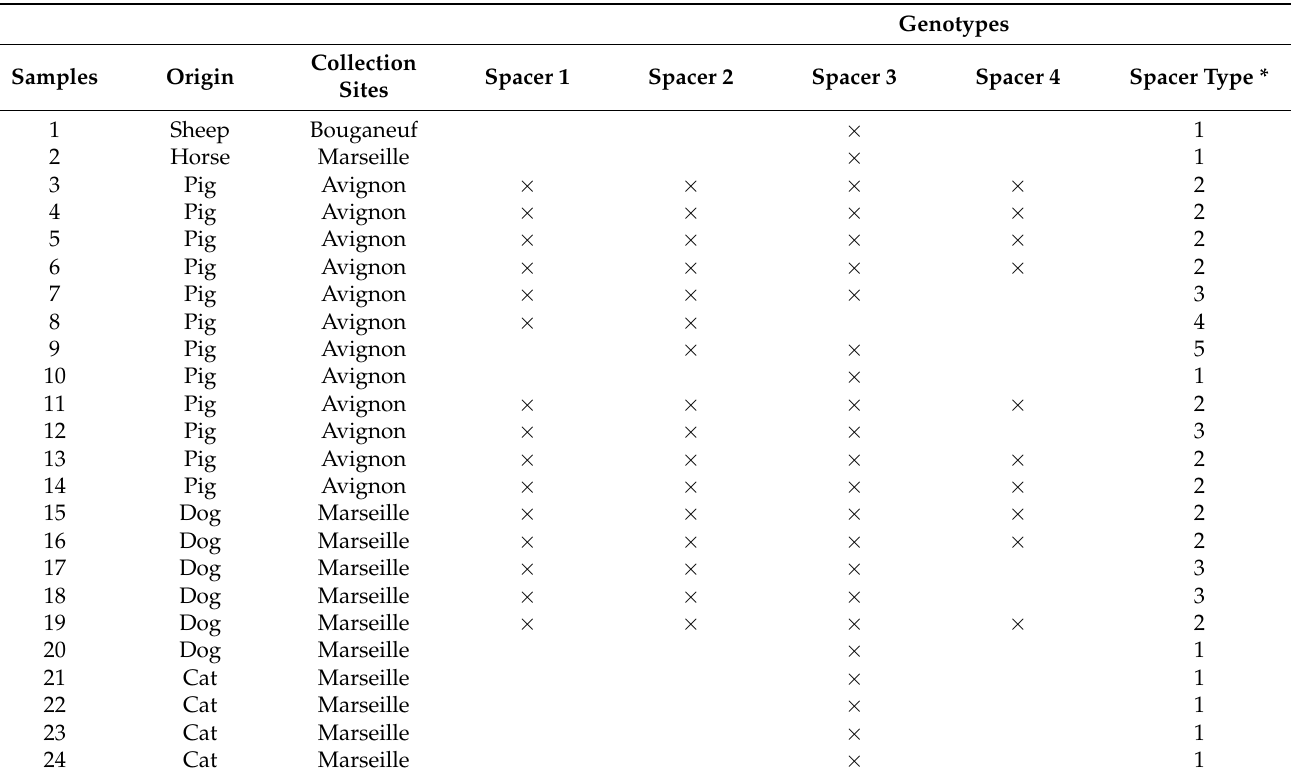
Figure 2. Molecular phylogenetic analysis, based on 16S rRNA partial gene, showed the position of Methanomassiliicoccus-like sequences detected in feces of pigs. The evolutionary history was inferred using the Neighbor-Joining method. The optimal tree with the sum of branch length = 0.82722721 is shown. The percentage of replicate trees in which the associated taxa clustered together in the bootstrap test (1.000 replicates) are shown next to the branches. The tree is drawn to scale, with branch lengths in the same units as those of the evolutionary distances used to infer the phylogenetic tree. The evolutionary distances were computed using the Maximum Composite Likelihood method and are in the units of the number of base substitutions per site. The analysis involved 14 nucleotide sequences. All positions containing gaps and missing data were eliminated. There were a total of 415 positions in the final dataset. Evolutionary analyses were conducted in MEGA7. Bootstrap values ≥ 95% are indicated at nodes. In red: out of group. Species highlighted: methanogens species detected in this study. Table 6. Summary of the results of multispacer sequence